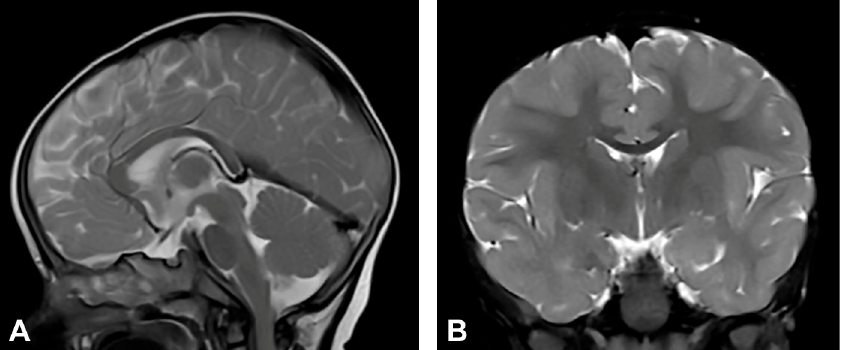
Figure 4. (Case 4) ( A ) Sagittal and ( B ) coronal T2W magnetic resonance images at the age of nine months without pathological findings.